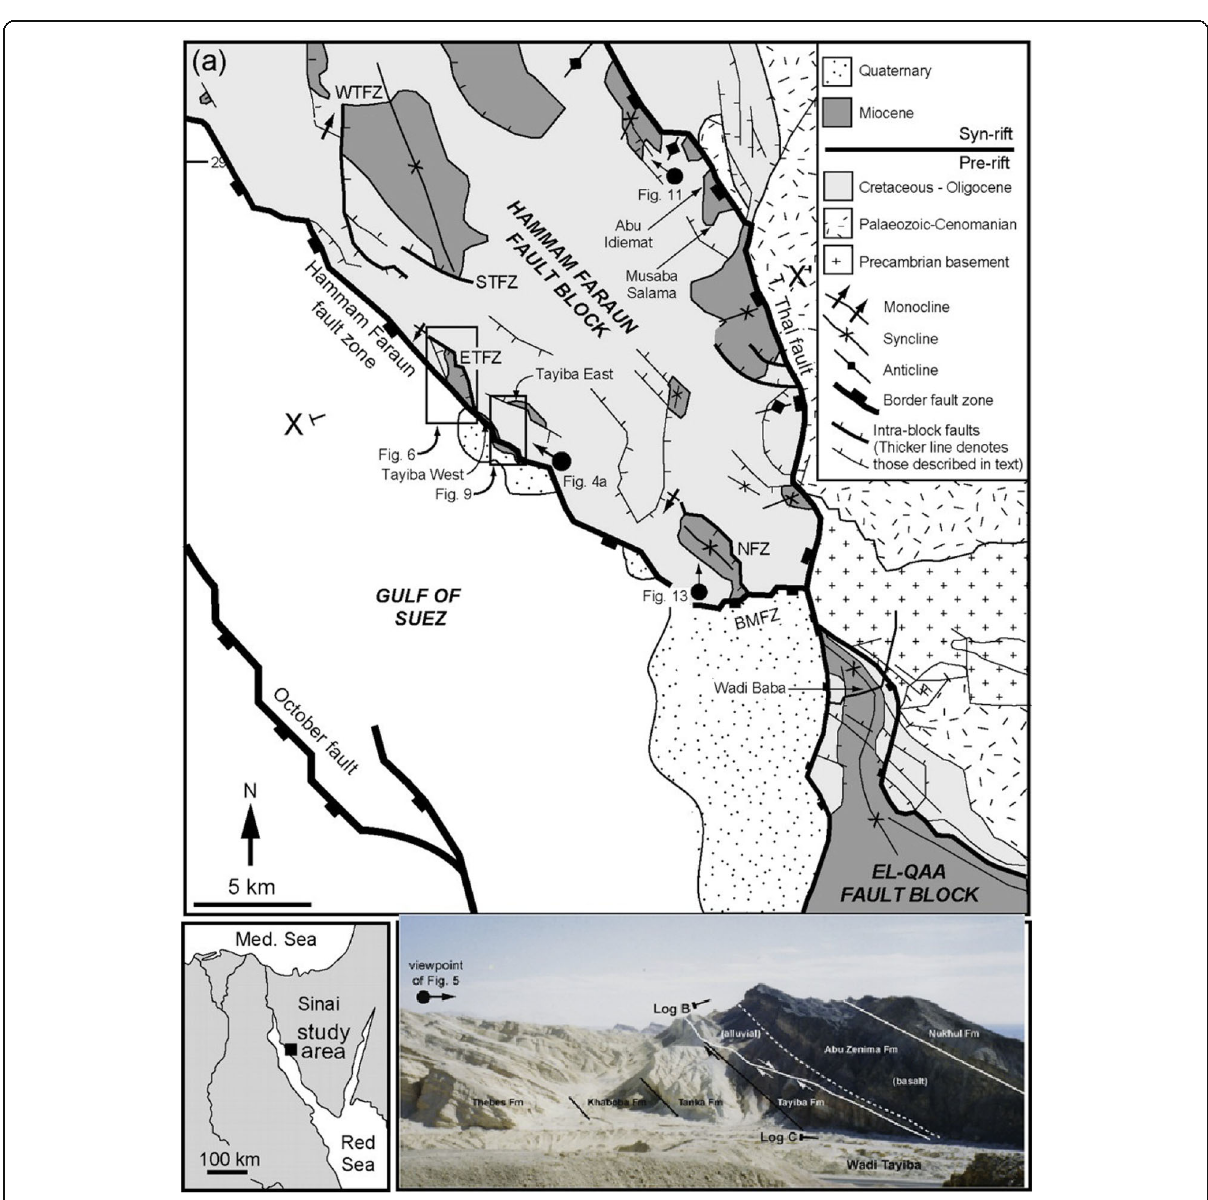
Fig. 1 Photograph stratigraphic correlation through the Wadi Tayiba. Modified from Jackson et al.